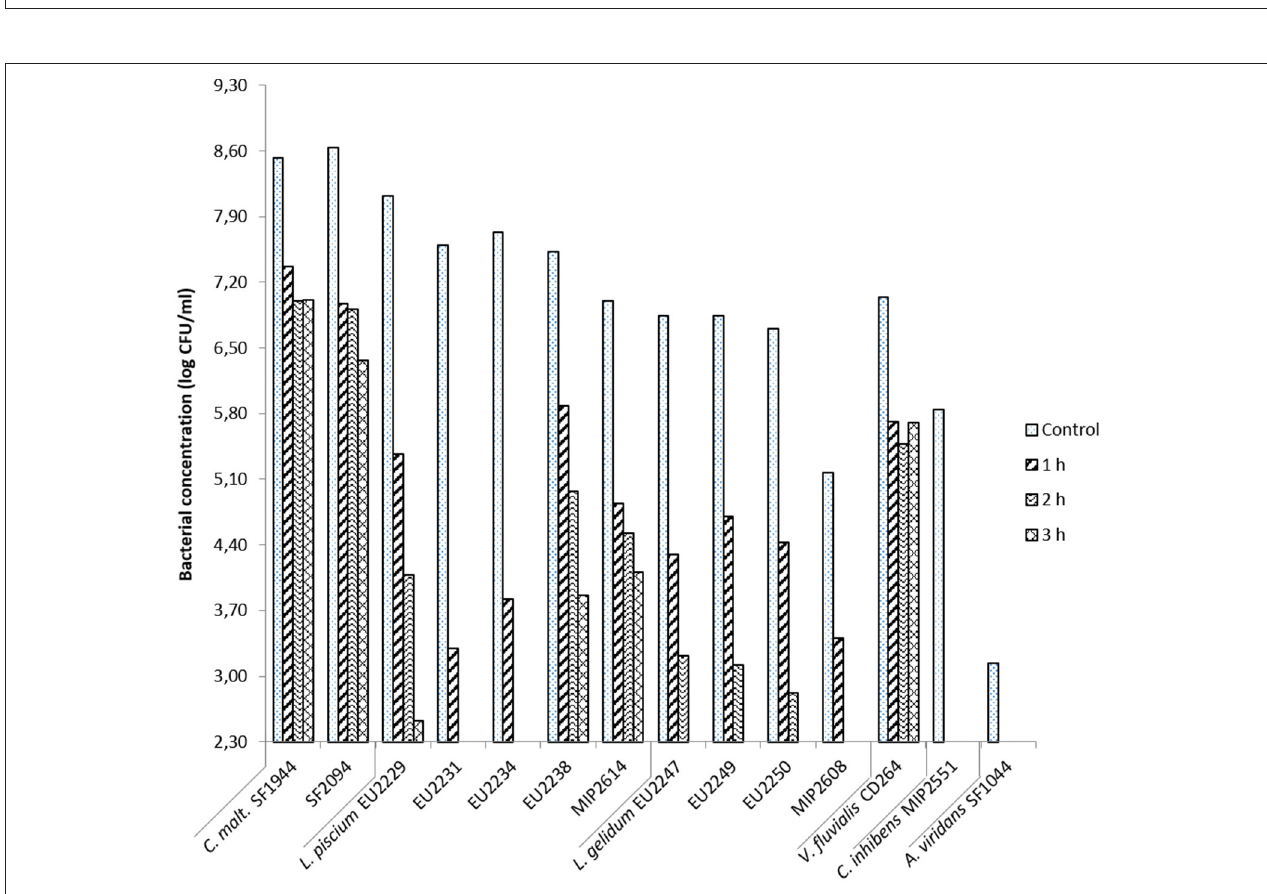
FIGURE 4 | Chitosan D antimicrobial activity at 0.02% in salmon juice at pH 6.0 toward protective cultures strains after 1, 2, and 3 h of treatment.